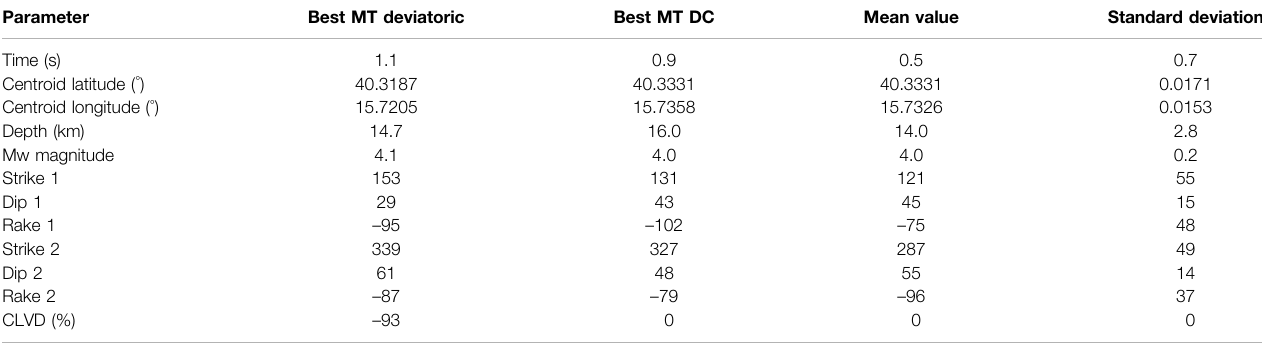
TABLE 1 | Summary of the best solution for the deviatoric and double couple (DC) moment tensor inversion, reporting mean and standard deviation according to the DC solutions. Centroid time is de fi ned with respect to the assumed origin time, October 26, 2017 22:38:35.3. Parameter Best MT deviatoric Best MT DC Mean value Standard deviation Time